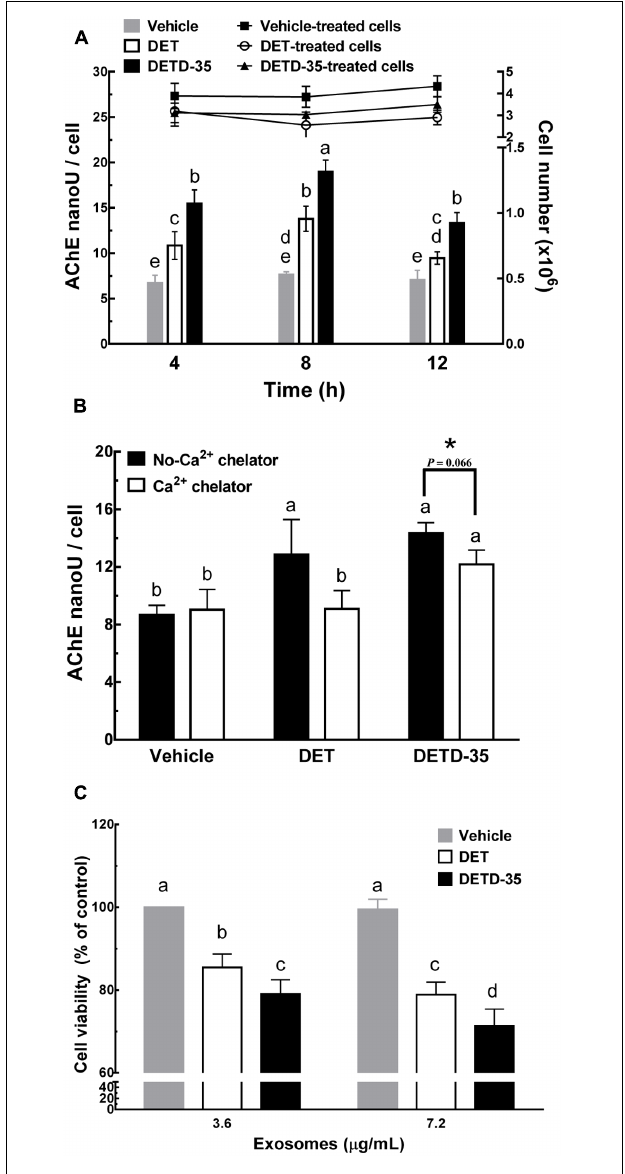
FIGURE 4 | Deoxyelephantopin and DETD-35 promoted a time-dependent release of TNBC cell-derived exosomes. (A) MDA-MB-231 cells were treated with vehicle (0.5% DMSO), DET (11 µ M), and DETD-35 (3 µ M) at the indicated time periods (4, 8, and 12 h), and then the TNBC-secreted exosomes were collected from culture media using differential centrifugation. The activity of acetylcholinesterase (AChE), an exosome marker protein, was determined using fluorescence microplate reader. Data are mean ± SEM, n = 3. (B) MDA-MB-231 cells were pre-treated with 20 µ M calcium chelator BAPTA-AM for 30 min, and then treated with either vehicle, DET or DETD-35 for 8 h. The release of treated cell-derived exosomes was separated by differential centrifugation. Data are mean ± SEM, n = 3. (C) The exosomes (3.6 and 7.2 µ g/mL, respectively) collected from the culture medium of vehicle–, DET–, or DETD-35–treated cells) were added into the freshly cultured MDA-MB-231 cells for 24 h, and the TNBC cell viability was determined using MTT assay. Different letters indicate significant differences (one-way ANOVA, P < 0.05). The difference of DETD-35–treated cells with or without BAPTA-AM pretreatment presented in (B) was further analyzed by student t -test and labeled with